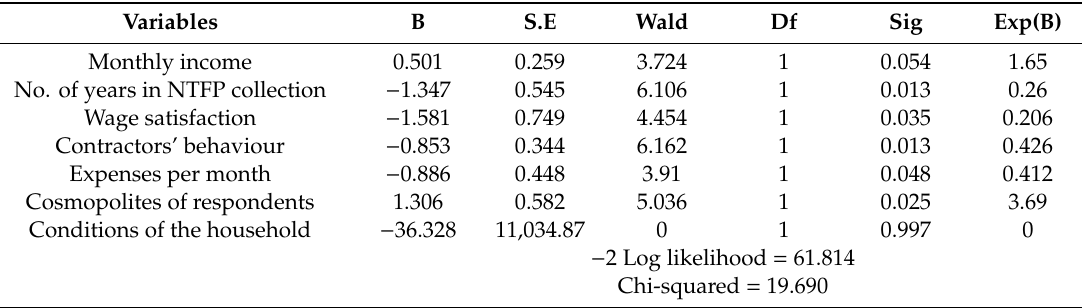
Table 3. Results of the binary logistic regression